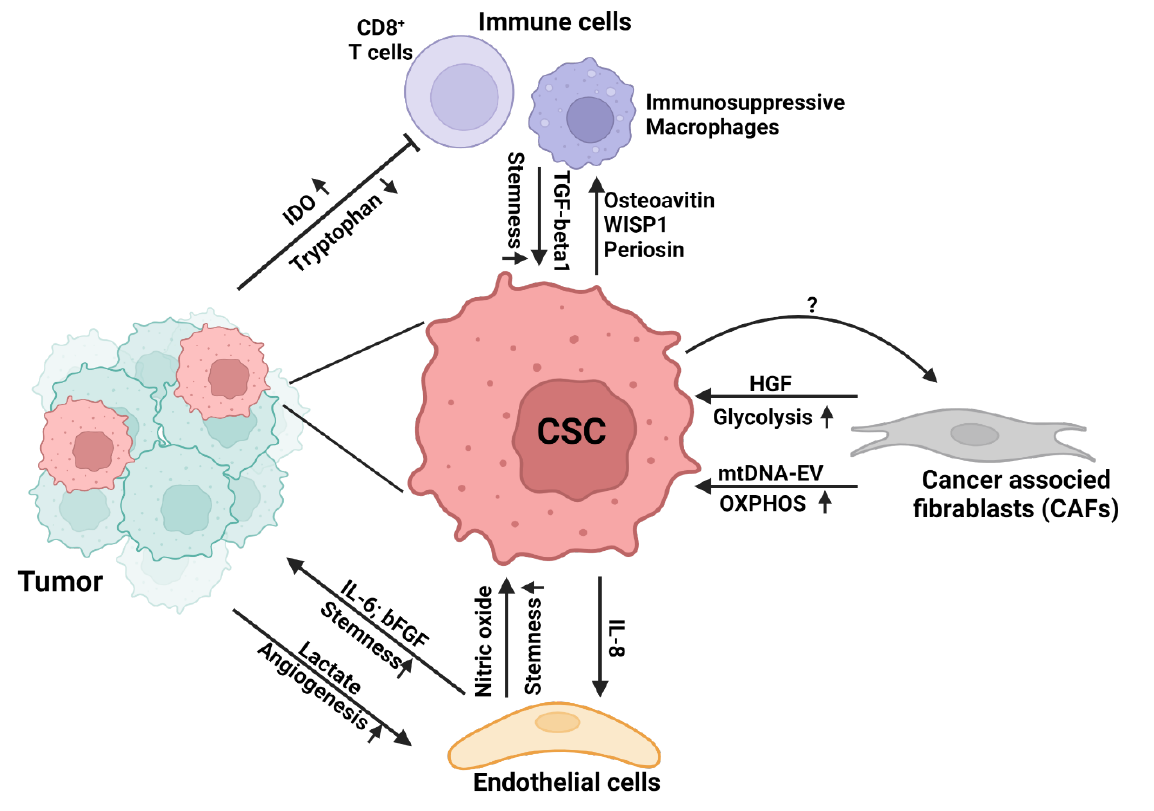
Figure 2. Cancer-immuno-metabolic crosstalk. Schematic diagram illustrating the bi-directional in- teraction of tumor cells including CSCs with the neighboring non-tumor cells through TME